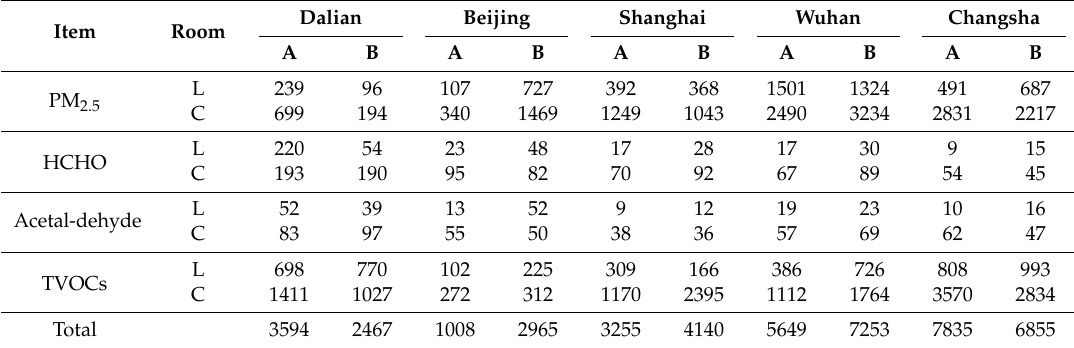
Table 4. Child’s daily exposure to PM 2.5 , HCHO, acetaldehyde and TVOCs in the investigated households ( µ g/day).